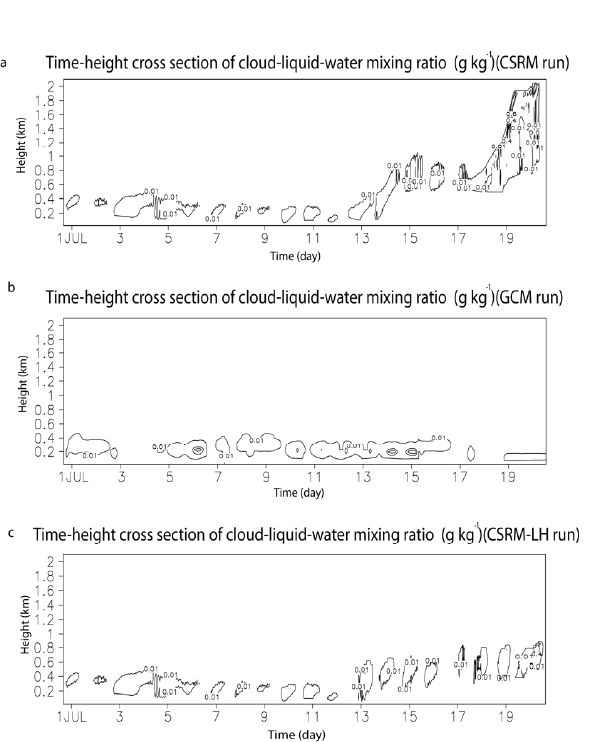
Fig. 7. Time-height cross section of cloud-liquid-water mixing ra- tio (gkg − 1 ) for (a) the CSRM run, (b) the GCM run, and (c) the CSRM-LH run. Contours are at 0.01, 0.4, and 0.6gkg − 1 .